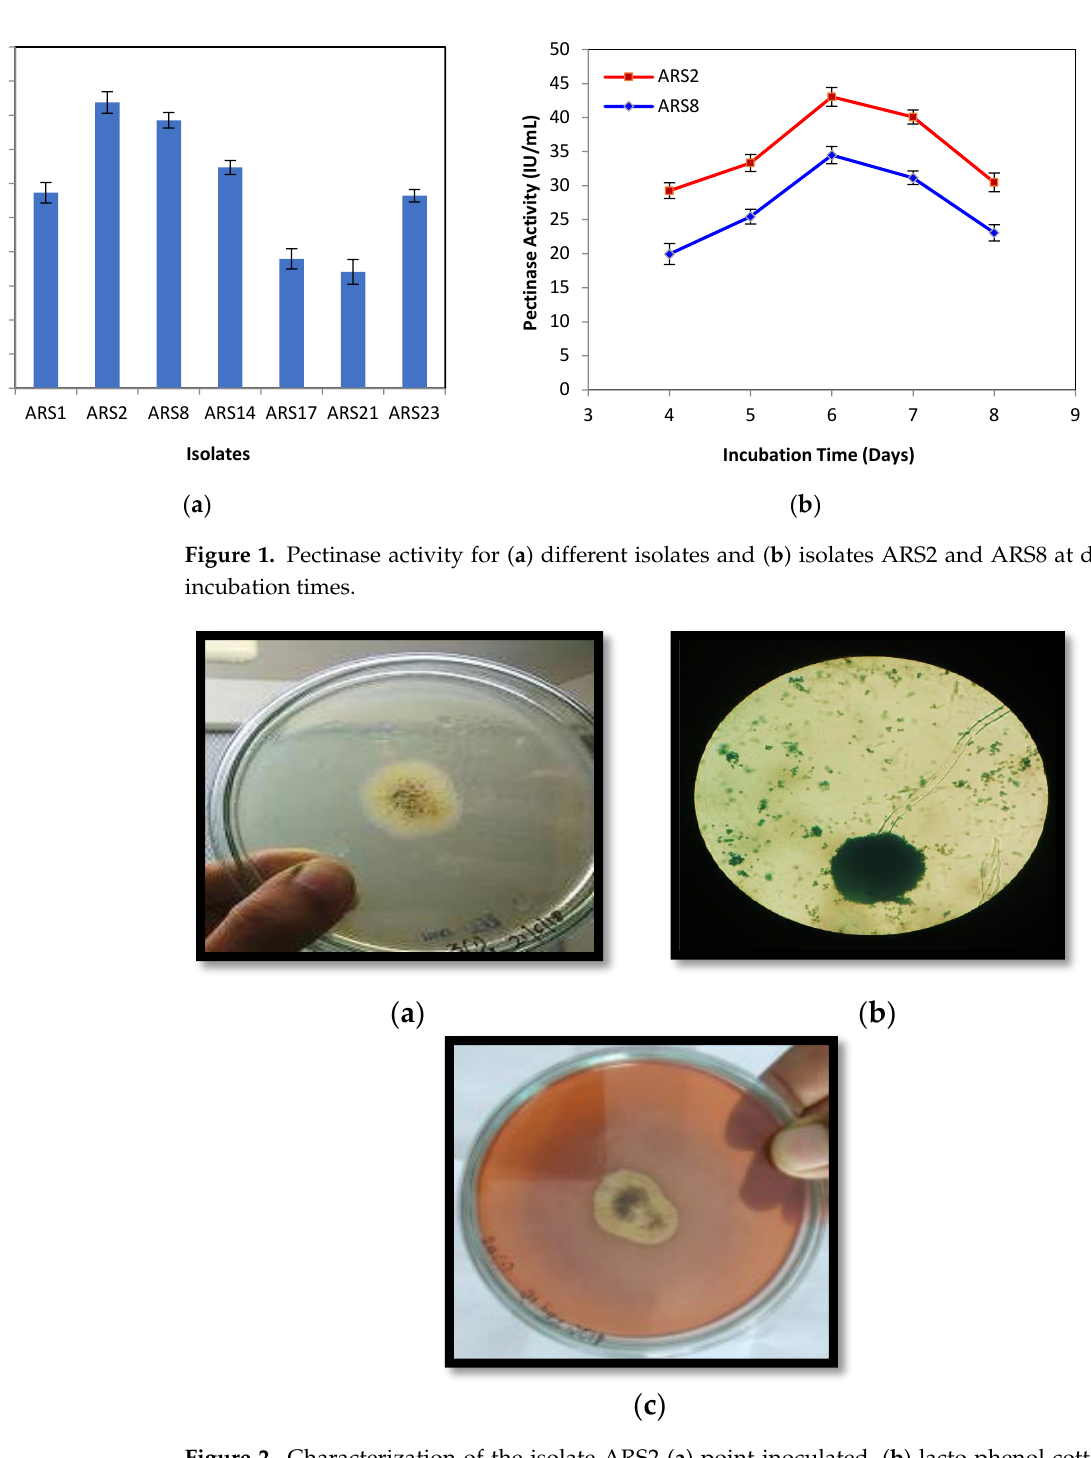
Figure 2. Characterization of the isolate ARS2 ( a ) point inoculated, ( b ) lacto phenol cotton blue staining (40×) scale bar (100 µm), and ( c ) qualitativescreening based on the zone of clearance.